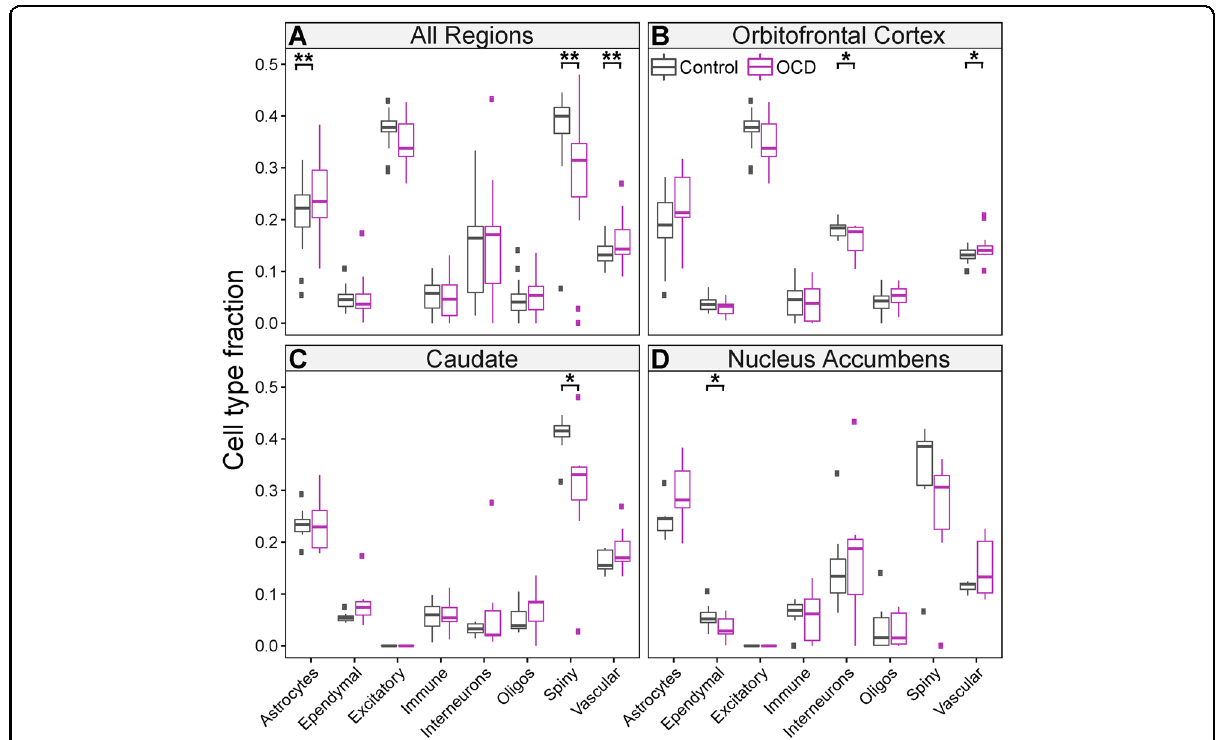
Fig. 3 Cell type fractions in OCD subjects and unaffected comparison subjects. Cell type fractions were determined across all brain regions for OCD subjects (purple) and unaffected comparison subjects (grey) separately. Gene expression patterns in single-cell data were used to estimate the fraction of eight broadly de fi ned cell types: astrocytes, ependymal cells, excitatory neurons, immune cells, interneurons, oligodendrocytes, medium spiny neurons (a.k.a. spiny projection neurons), and vascular cells. A Cell type fractions for global analysis (combined OFC, caudate, and nucleus accumbens). B Cell type fractions in the OFC, C Caudate, and D Nucleus accumbens. Boxplots are displayed, where ** indicates p < 0.01 and * indicates p < 0.05 (uncorrected for multiple comparisons). The mean cell type fractions were computed based on all four brain regions; however, when the cell type did not exist in the brain region, it was not included in the calculation. Thus, the mean cell type fraction for the excitatory neurons was based only on the cortical regions and the mean cell type fraction for spiny projection neurons was based on the caudate and nucleus accumbens